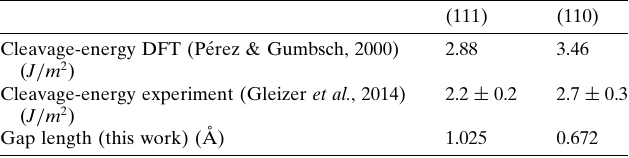
Table 13 Cleavage energies of silicon (obtained from DFT calculations/experi- ment) against the length of the structural gaps calculated in this